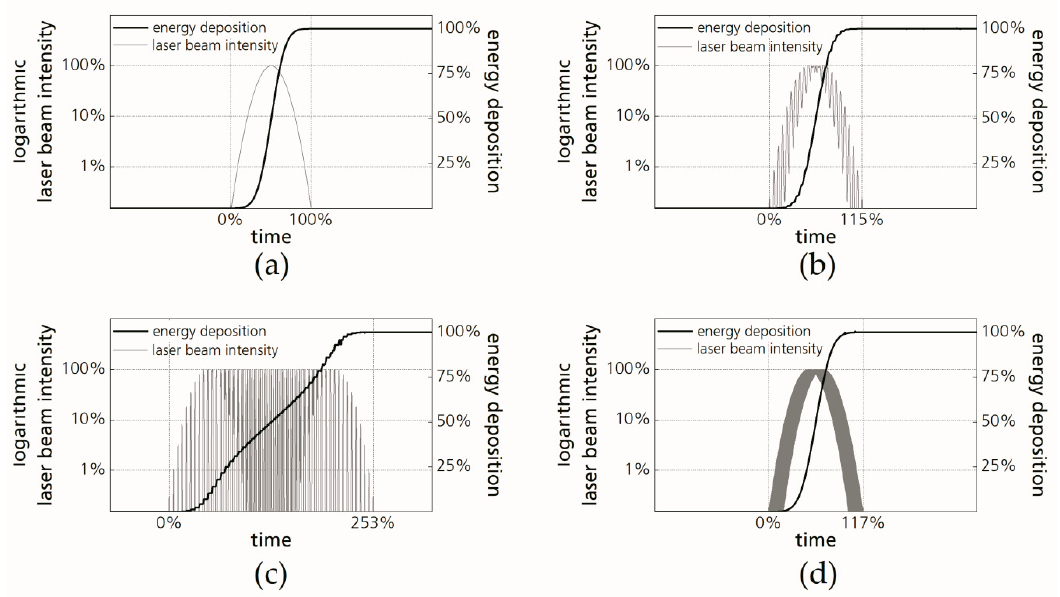
Figure 9. Schematic comparison of the local intensity profile and energy deposition for one certain material position along the cut path as function of the time for: ( a ) Static laser beam shaping; and di ff erent values of the longitudinal, linear beam oscillation parameters: ( b ) 60 µ m amplitude and 250 Hz frequency; ( c ) 500 µ m amplitude and 250 Hz frequency; ( d ) 60 µ m amplitude and 4000 Hz frequency. All axes of the four charts are scaled equally. Cutting speed and focal plane are constant and heat conduction and melt ejection have been disregard.